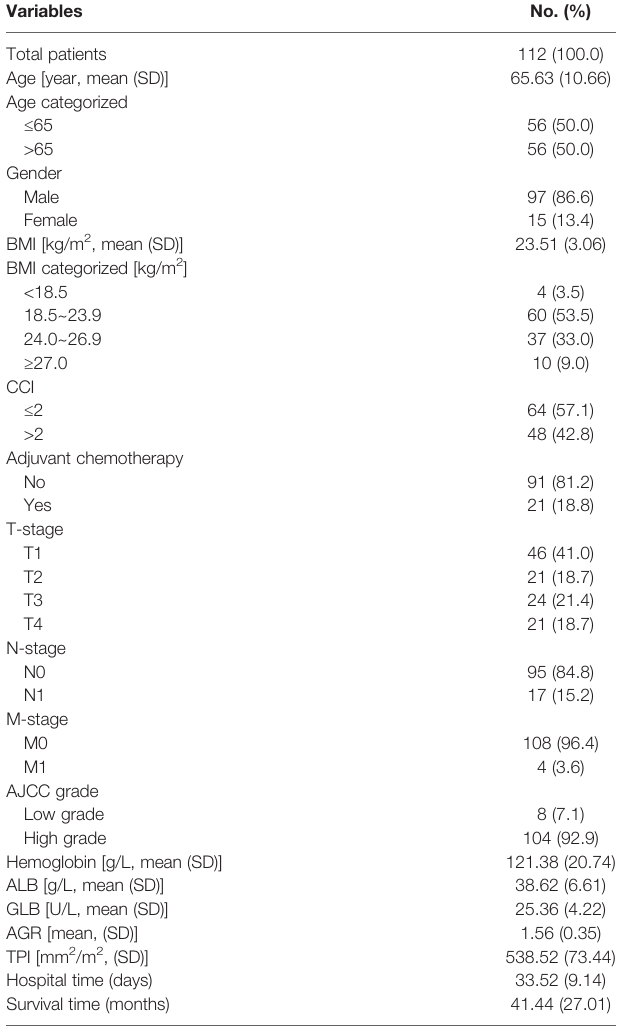
TABLE 1 | Baseline characteristics of included BCa